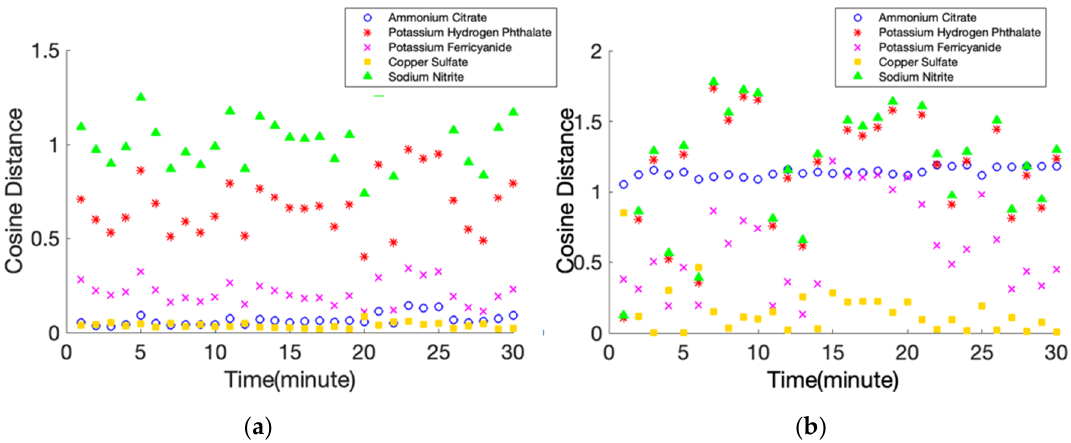
Figure 10. Classification results of 1.6 mg/L Copper Sulfate solution before and after the fusion of cross-correlation information. ( a ) Before the introduction of cross-correlation information; ( b ) after the introduction of cross-correlation information.